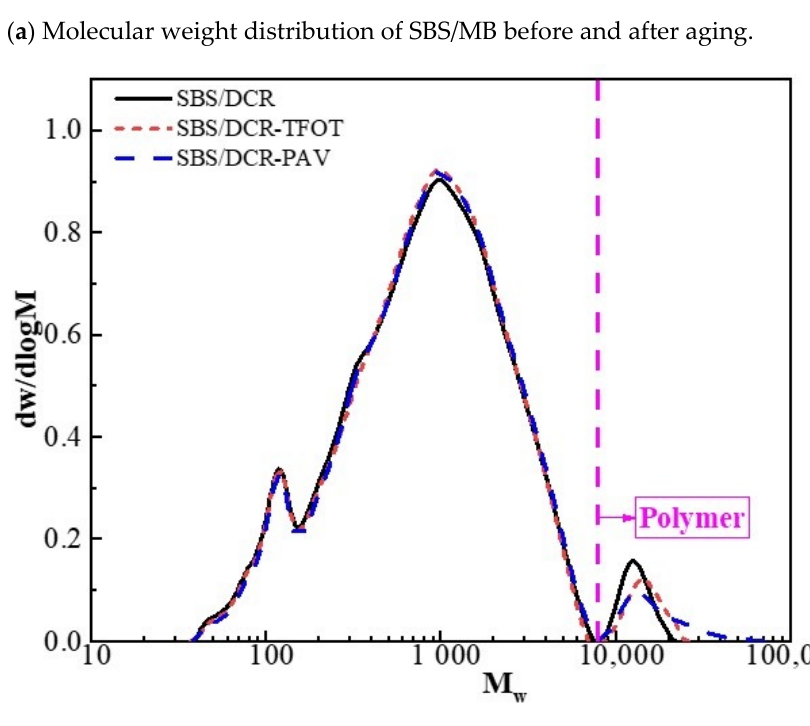
Figure 5. Molecular distribution of SBSMB and SBS/DCRMB in different aging conditions. Table 2. Molecular weight calculation of SBSMB and SBS/DCRMB before and after aging.